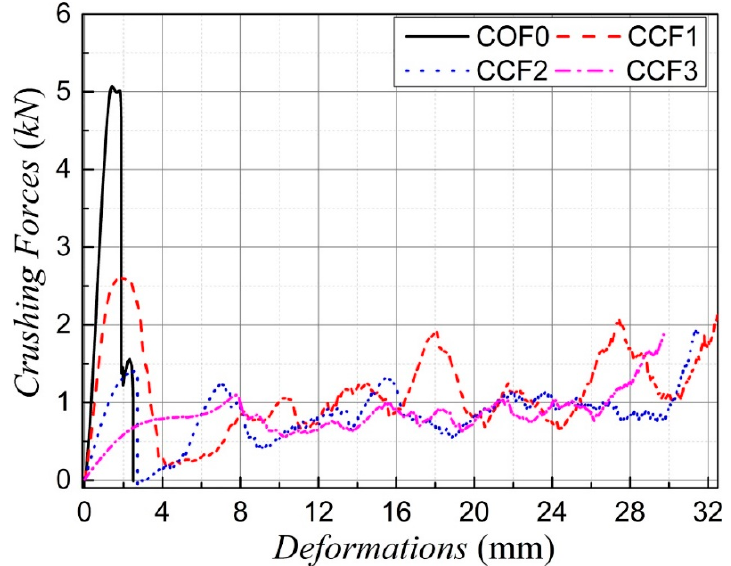
Figure 5. Typical crushing force-deformation curves of the four sample COF0, CCF1, CCF2, and CCF3 under uniaxial quasi-static compression in the y direction.